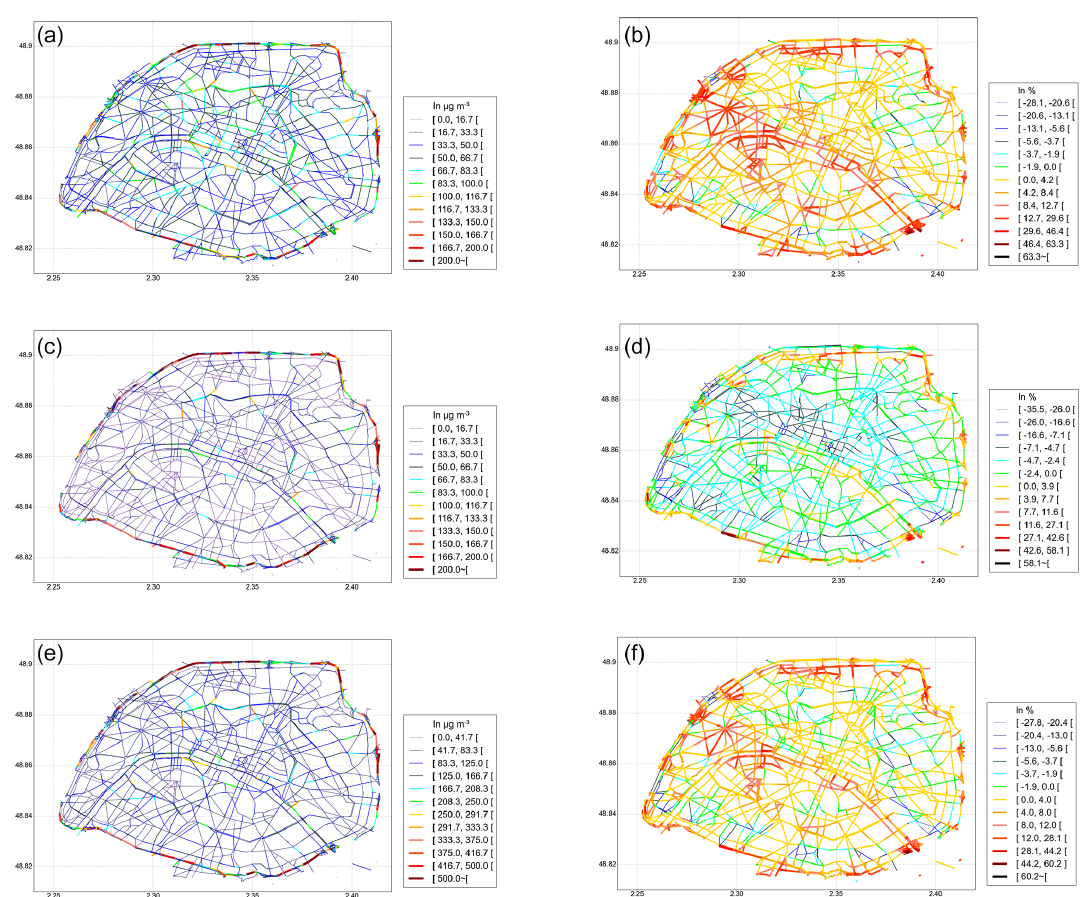
Figure B1. NO 2 (a, b) , NO (c, d) and NO x (e, f) concentrations simulated over Paris with SinG (a) and relative differences between SinG and MUNICH (b)